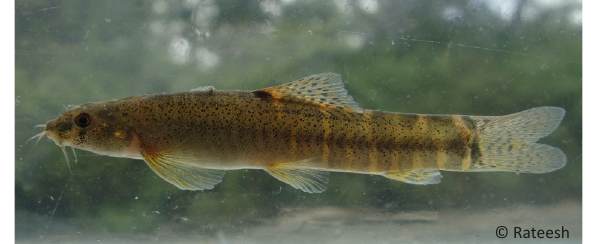
Image 18. Nemacheilus